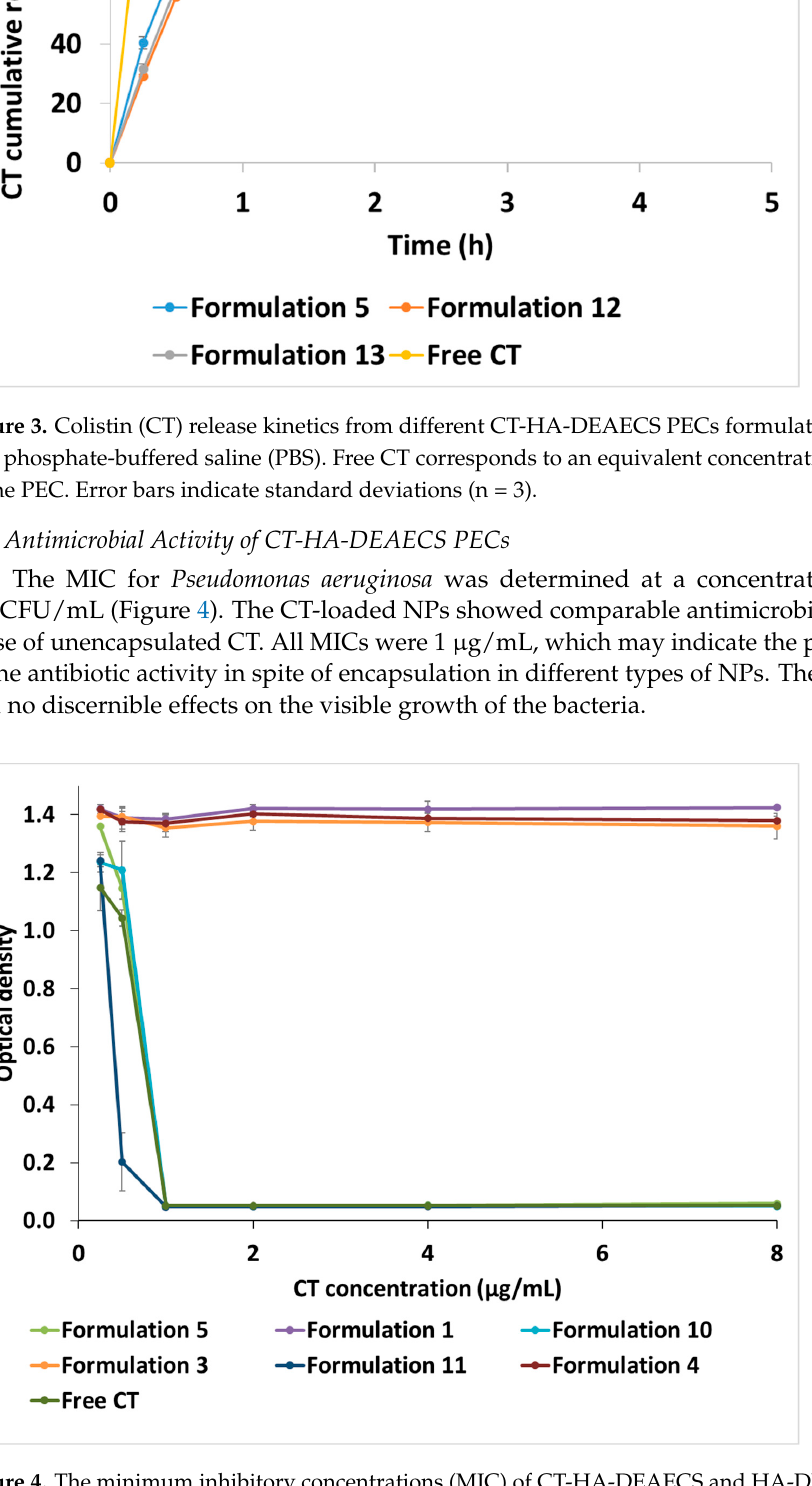
8 of 14 B Figure 2. Atomic force microscopy (AFM) images of Formulation 1 ( A ) and Formulation 5 ( B ). 2.3. In Vitro Release of CT from CT-HA-DEAECS PECs The study of release kinetics into PBS (pH 7.4) simulated the pattern of CT behavior